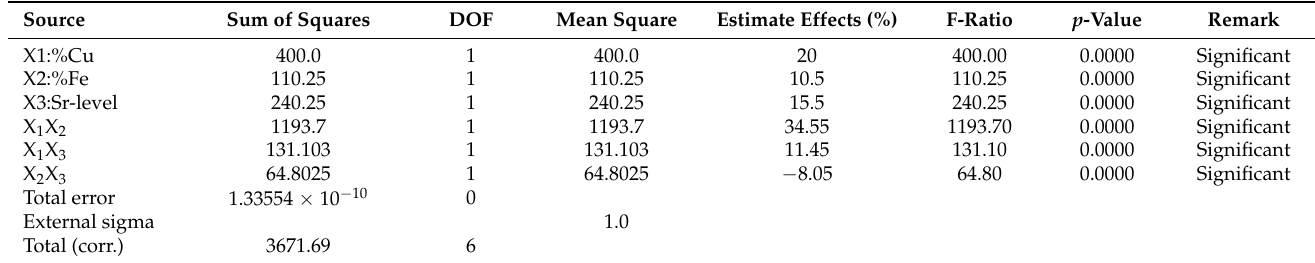
Table 8. Analysis of variance (ANOVA) for yield stress data (YS in MPa).